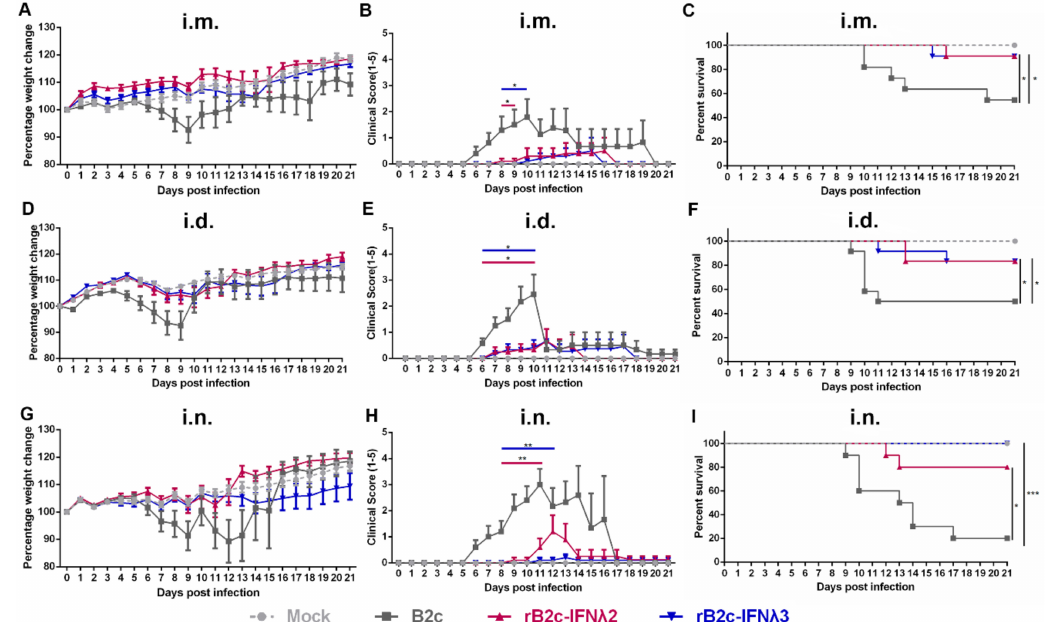
Figure 3. IFN- λ attenuates rRABV pathogenicity in mice. Five-week-old female BALB / c mice were inoculated i.m. (6 × 10 5 FFU), i.d. (1.5 × 10 5 FFU), or i.n. (150 FFU) with B2c, rB2c-IFN λ 2, rB2c-IFN λ